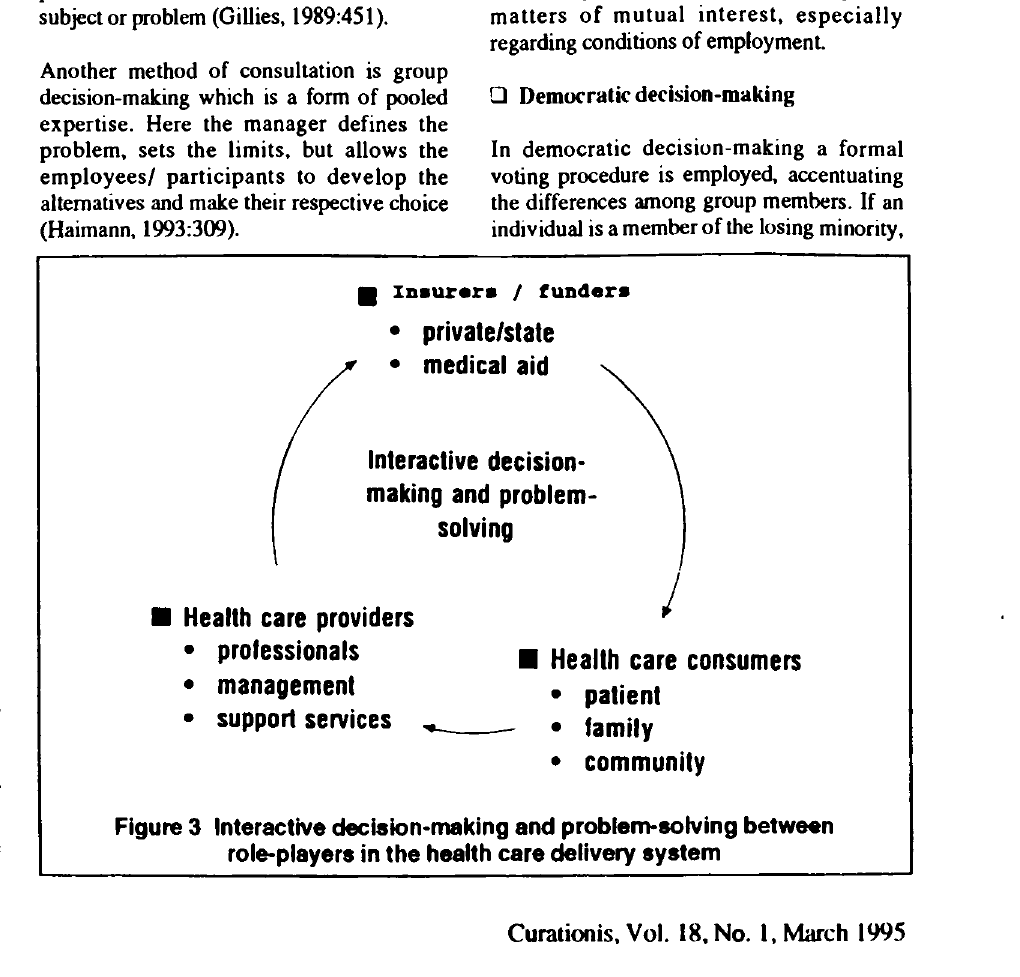
Figure 3 Interactive decision-making and problem-solving between role-players in the health care delivery